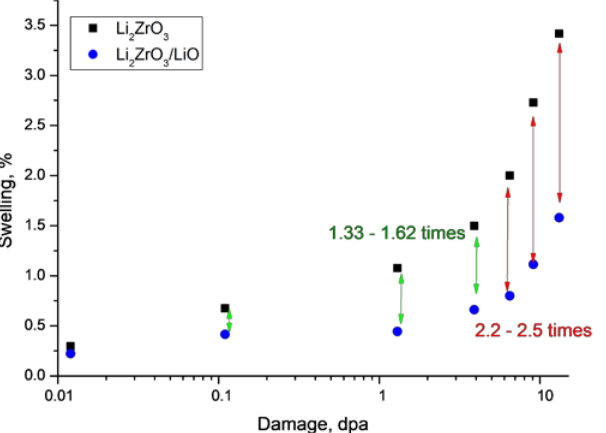
Figure 5. Results of the crystal lattice swelling depending on the irradiation dose (displacement values are presented on a logarithmic scale).